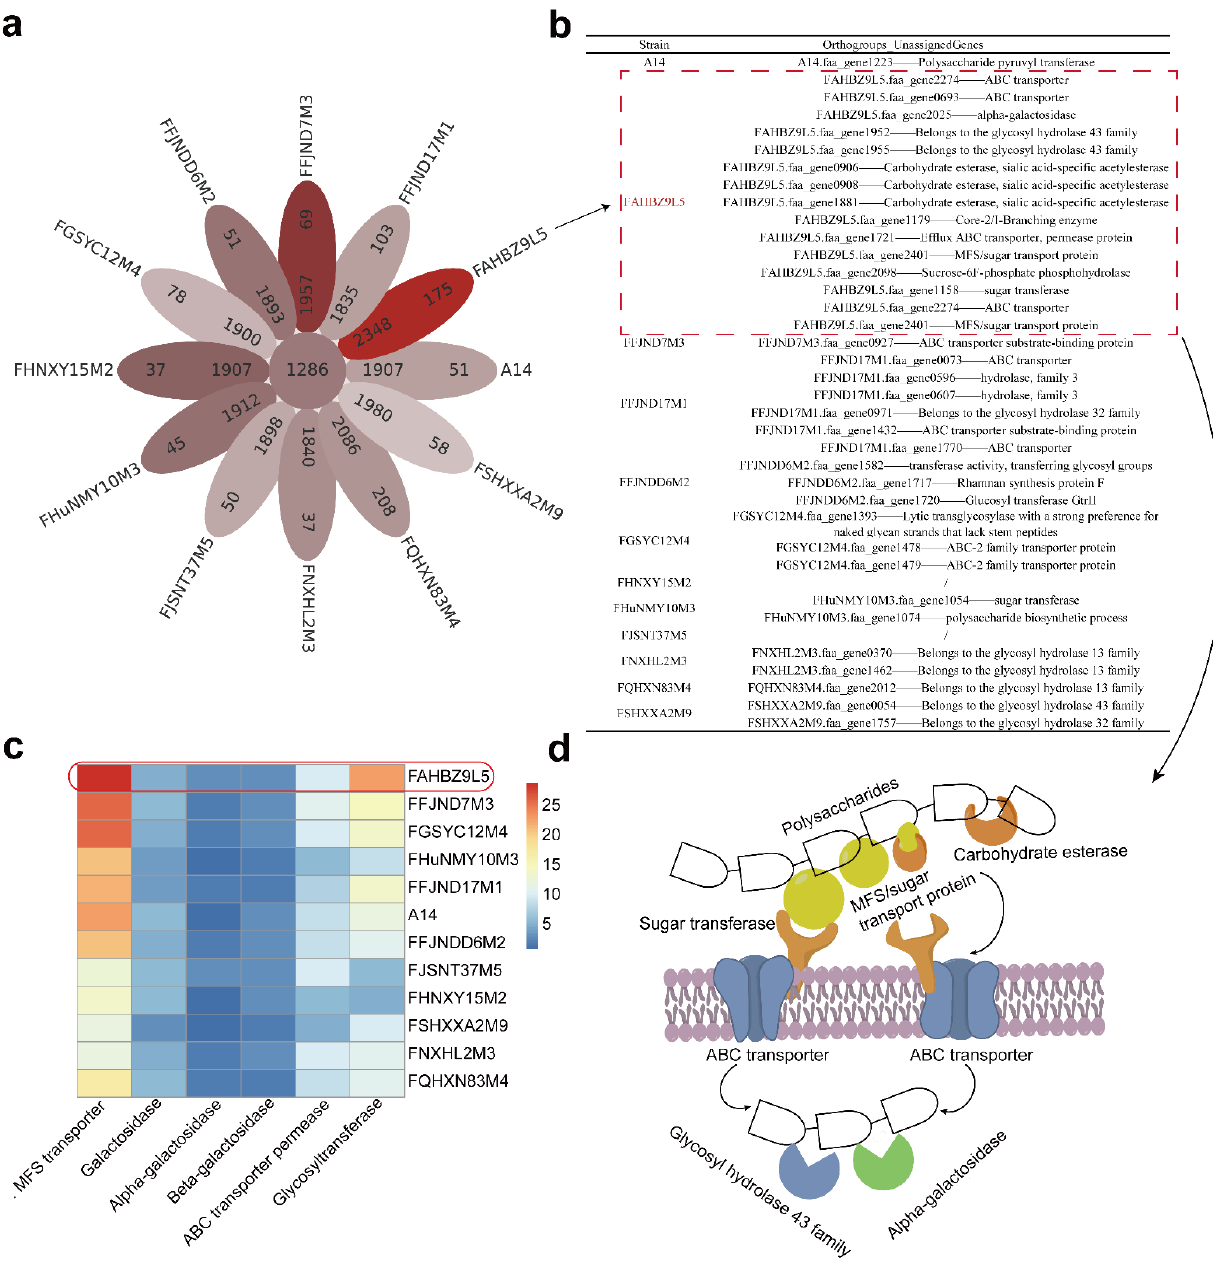
Figure 4. ( a ) The flower plot displays the core orthogroups ’ number (in the center), the sum number of genes of species, and the number of orthogroups ’ unassigned genes (in the petals) for the 12 B. pseudocatenulatum . ( b ) A set of related carbohydrate metabolism genes (orthogroups unassigned genes) of 12 B. pseudocatenulatum . ( c ) Heatmap representation accounts for gene numbers of